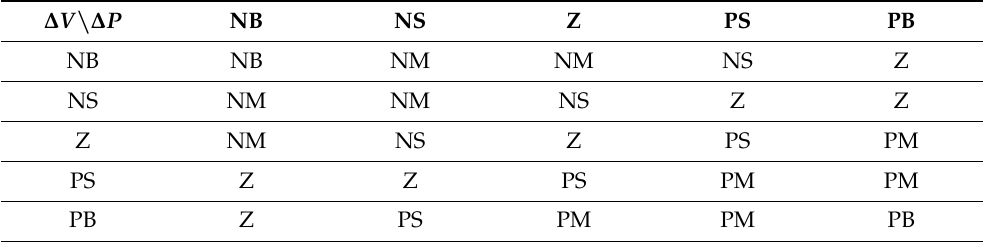
Table 5. FLC linguistic